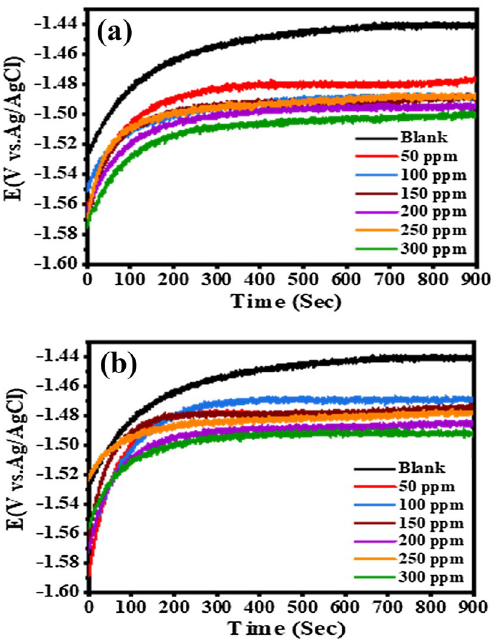
Figure 2. OCP curves of Al in 0.1 M NaOH solution containing different concentrations of ( a ) Cefx and ( b ) Cefz at 293 K.